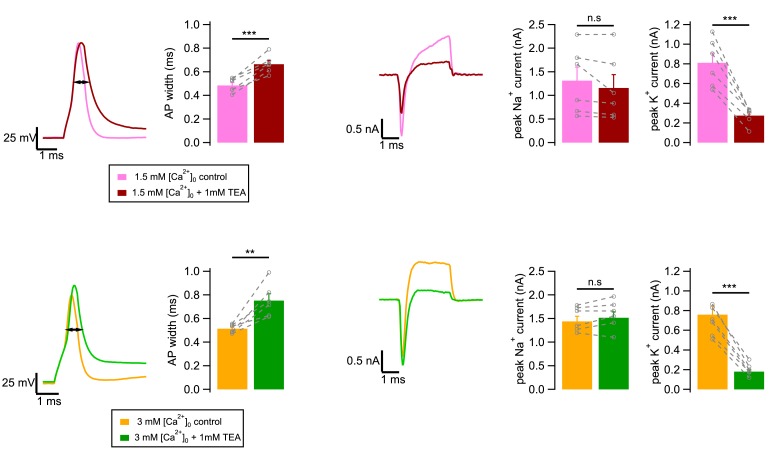
Effect of adding TEA on granule cell excitability.In these experiments, granule cells were examined under current clamp and voltage clamp, before and after addition of TEA. Under current clamp, we measured AP width in 1.5 mM [Ca2+]o at 0 mV, without (pink) or with (brown) 1 mM TEA. Likewise we measured AP width in 3 mM [Ca2+]o, without (yellow) or with (green) 1 mM TEA. Under voltage clamp, peak voltage-dependent Na+ and K+ currents were estimated by measuring the peak amplitudes of inward and outward current responses to depolarizing voltage pulses to 0 mV. Group results show significant increases in AP width with TEA, both in 1.5 mM [Ca2+]o and in 3 mM [Ca2+]o. Peak K+ currents are decreased in the presence of TEA, both in 1.5 mM [Ca2+]o and in 3 mM [Ca2+]o, while peak Na+ currents are not significantly changed. Levels of significance for statistical tests (paired t-test): **, p<0.01; ***, p<0.001.